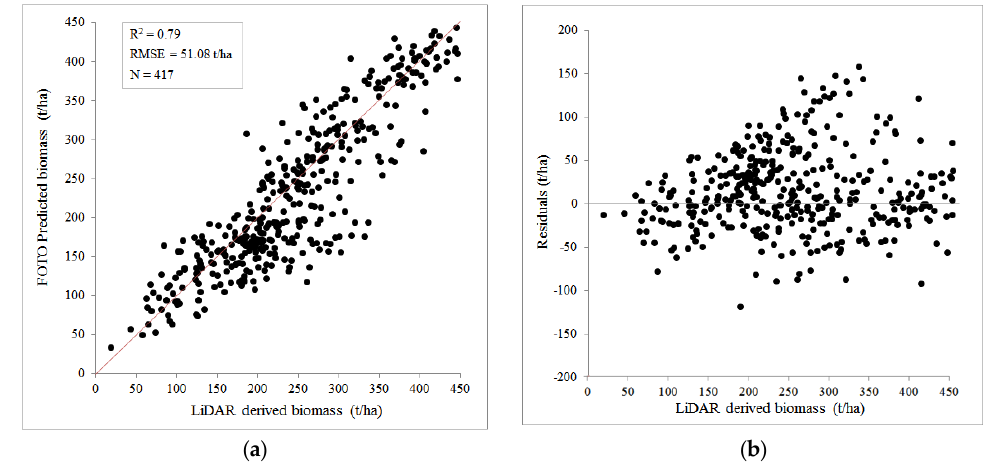
Figure 7. Validation results present ( a ) the correlation and ( b ) the residuals between the LiDAR-derived AGB and the FOTO-predicted AGB. The red line represents the 1:1 correspondence line.